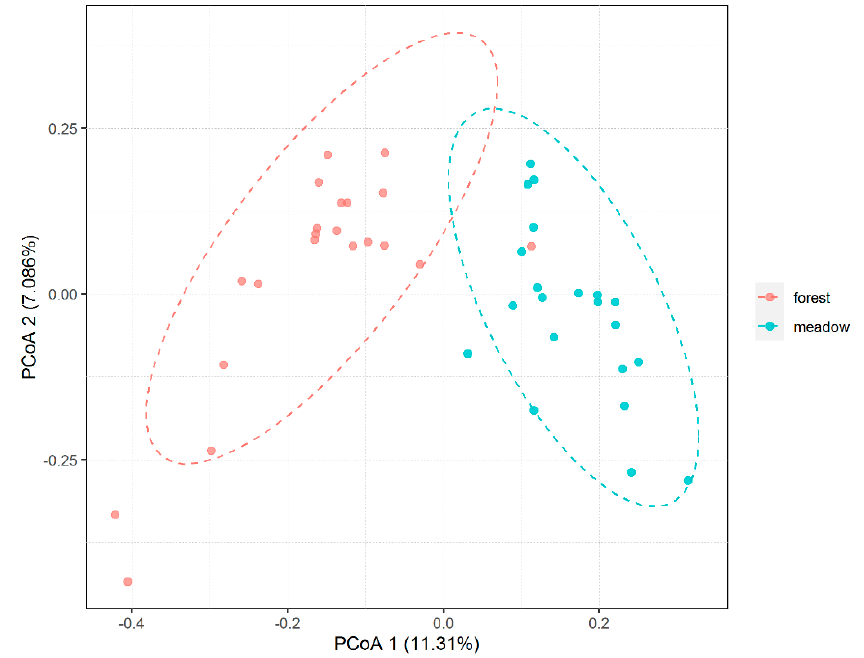
Figure 2. Principal coordinates analysis (PCoA) based on Bray − Curtis distance of fungal communities between forest (below the treeline) and meadow (above the treeline). Ellipses were added according to the sample grouping of experimental design and specified a confidence of 0.95 when fitting the ellipse radius.